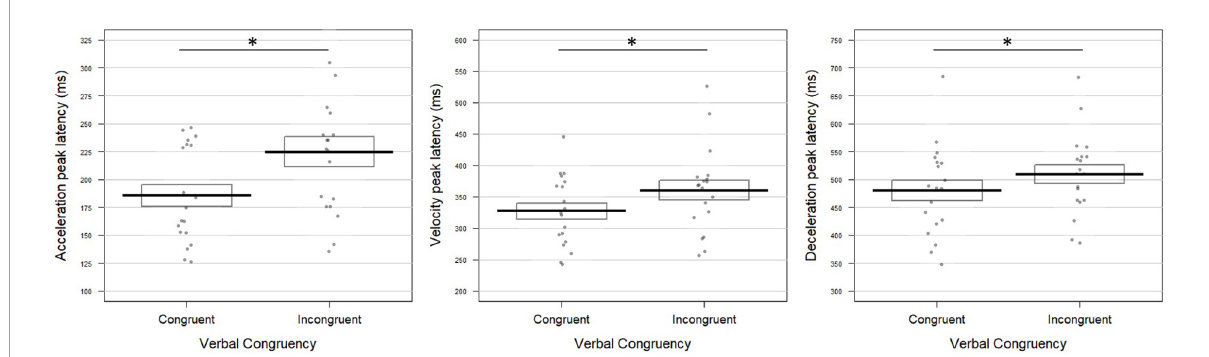
FIGURE5 Verbal congruency effect on the movement tangential profile in Experiment 2. Latencies (in milliseconds) of the acceleration (left panel) , velocity (middle panel) , and deceleration peaks (right panel) were longer when pointing toward both upward (+45 ◦ ) and downward (–45 ◦ ) targets upon incongruent (“à droite en haut”/ right up and “à droite en bas”/ right bottom ) with respect to congruent (“en haut à droite”/ up right and “en bas à droite”/ bottom right ) verbal instructions (acceleration: t = –3.40; p = 0.003; velocity: t = –3.05; p = 0.005; deceleration: t = –2.21; p = 0.031). The conventions are the same as in Figure 2 . The symbol ∗ indicates a significant difference between